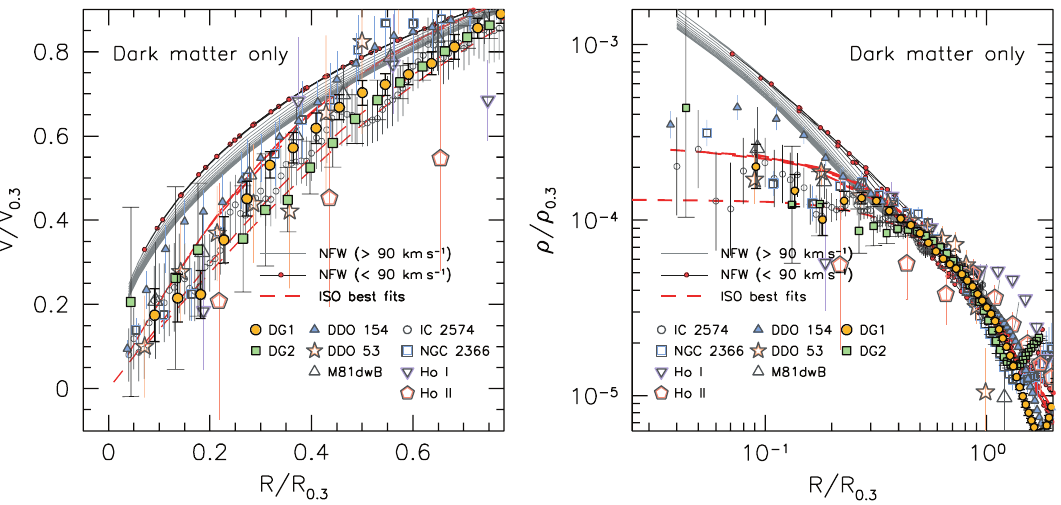
Figure 3. Left panel: Comparison of the RCs from ( a ) 7 dwarf galaxies from THINGS; ( b ) the two galaxies DG1 and DG2 simulated by [58], to the NFW (solid lines), and pseudo-isothermal (ISO) profiles (red dashed line). The NFW RCs with V 200 in the range 10–90 km/s are highlighted by small red dots. The rotation velocity V is scaled to V 0.3 , namely the value of V at R 0.3 , representing the distance at which d log V = 0.3. Right panel: same as the left, but for the density profiles (figure reproduced from d log R